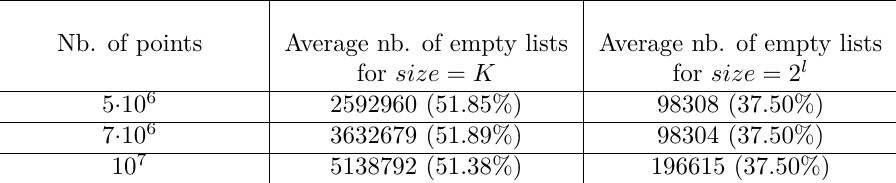
Table 3: Test the rate of memory use of a hash table